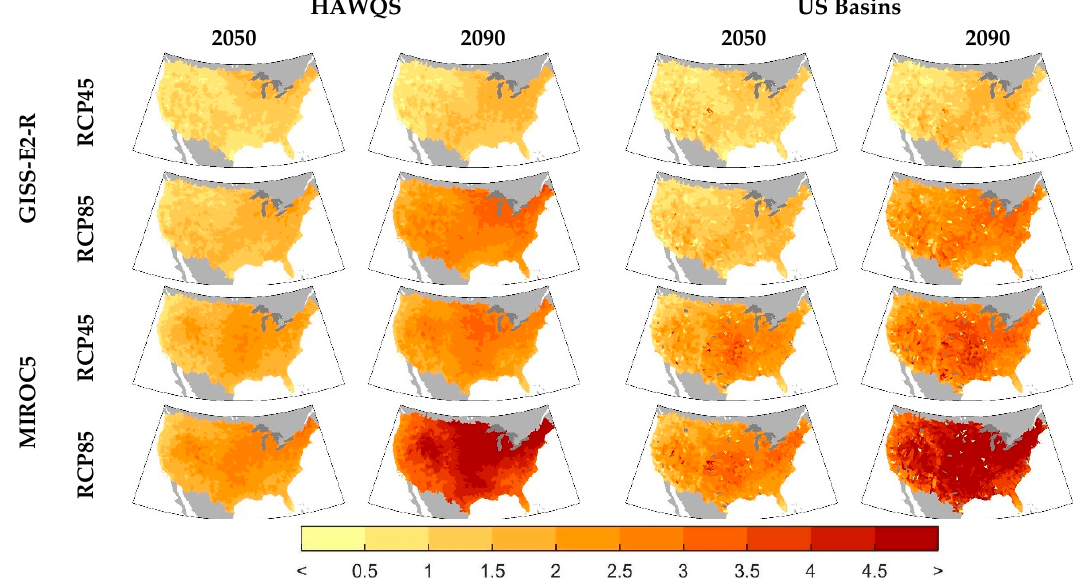
Figure 7. Changes (°C) in mean projected ( left ) HAWQS and ( right ) US Basins water temperature at the HUC ‐ 8 watershed scale for both the GISS ‐ E2 ‐ R and MIROC5 climate models, two emissions scenarios, and two eras.